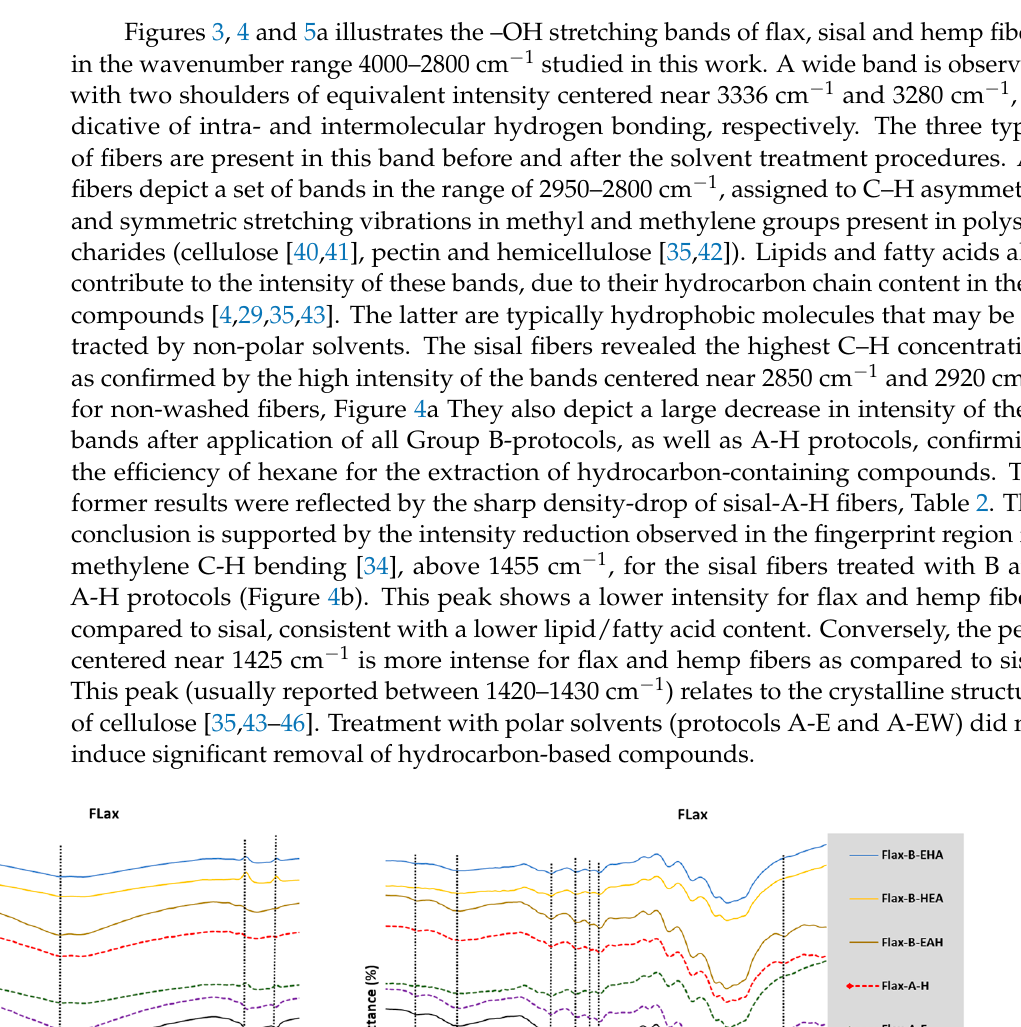
( b ) Figure 4. Spectra of sisal fibers before washing (NW) and after washing (B-EHA, B-HEA, A-E, A-H, B-EAH, A-EW). ( a ) Range 2800–3800 cm − 1 , ( b ) range 800–1800 cm − 1 . The band near 1730 cm − 1 corresponds to carboxyl/aldehyde groups of the uronic acids present in hemicellulose [24–28,30,35,42,47–51], carbonyl/carboxyl groups in pectin [52], lignin segments [4,30,51,53] and aliphatic fatty acids that constitute the waxy fraction of fibers [30]. The wide band centered near 1630 cm − 1 is assigned to C=C double bonds in the aro- matic moieties present in lignin [30], which may overlap with water OH bending [42,52– 55]. The peaks near 1365 cm − 1 (for flax and hemp) and 1373 cm − 1 (for sisal) are character- istic of C-H bending in cellulose and hemicellulose [35,36,53,55–57]. Oh et al. [54] reported that a shift of this band to a higher wavenumber could be assigned to a less ordered cel- lulose structure. The band centered at 1313–1317 cm − 1 observed in Figures 3–5b is assigned to CH 2 wagging and is characteristic of crystalline cellulose, while the band near 1336 cm − 1 is due to C–O–H in-plane bending and is a contribution from amorphous cellulose [49].